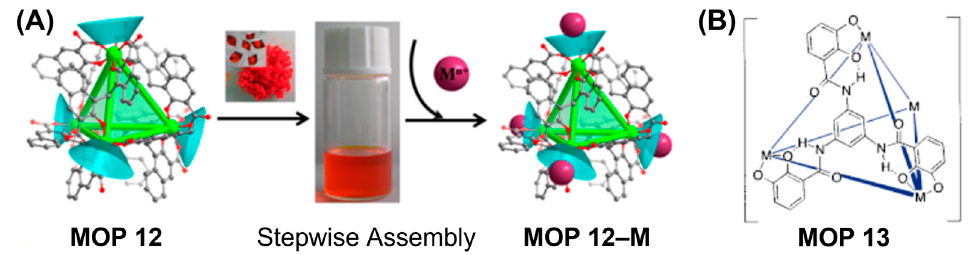
Figure 9. ( A ) Assembly of the tetrahedron MOP 12 with calixarene-like coordination-active vertices for potential metal ion trapping. ( B ) Titanium-based tetrahedron metal cluster MOP 13. Reprinted by permission from Refs. [59,112]. Copyright 1998 from Wiley-VCH and copyright 2017 from American Chemical Society. Table 1. Methane storage properties of MOP 9 (M 12 (cdc) 12 , M = Cu, Cr, Mo) cages in comparison